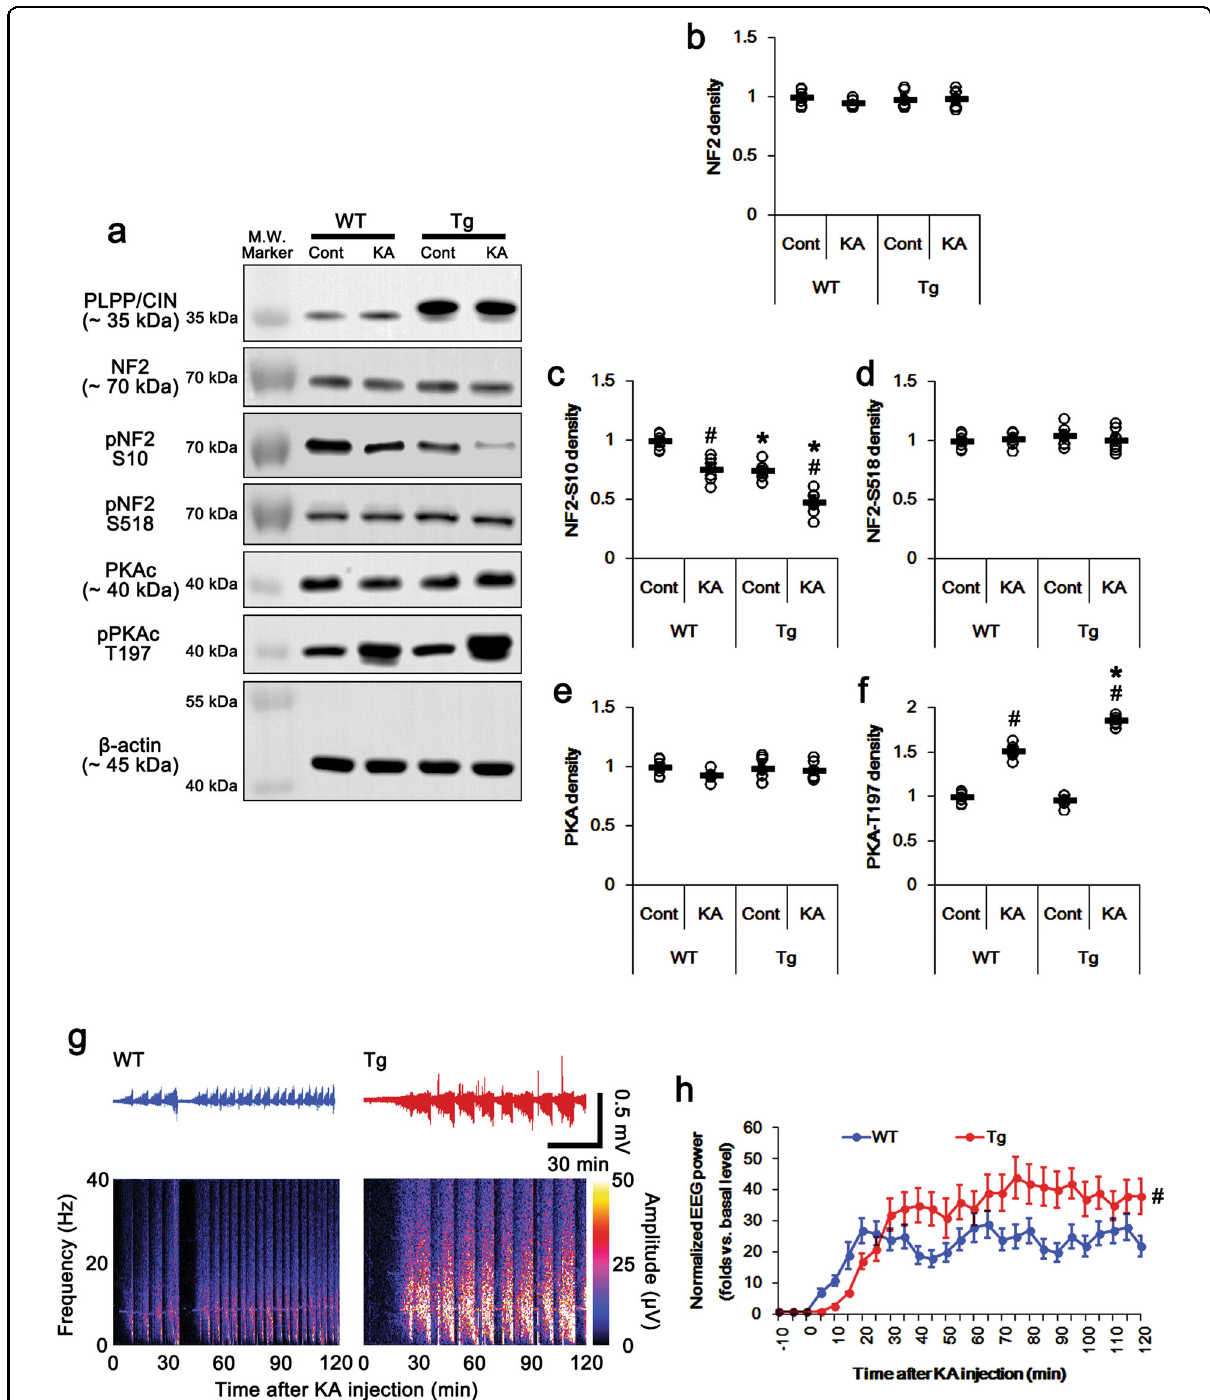
Fig. 2 Effects of PLPP/CIN over-expression on NF2 phosphorylation and seizure activity in response to KA. a Representative western blots of PLPP/CIN, NF2, pNF2-S10, pNF2-S518, PKAc, and pPKAc in WT and and PLPP/CIN Tg mice in vivo. b – f Quanti fi cation of NF2, pNF2-S10, pNF2-S518, PKAc, and pPKAc levels. Open circles indicate each individual value. Horizontal bars indicate mean value (* ,# p < 0.05 vs. WT and control animals, respectively; n = 7). g Representative EEG traces and frequency – power spectral temporal maps in response to KA. h Quanti fi cation of total EEG power (seizure intensity) in response to KA ( # p < 0.05 vs . WT animals; n = 7,